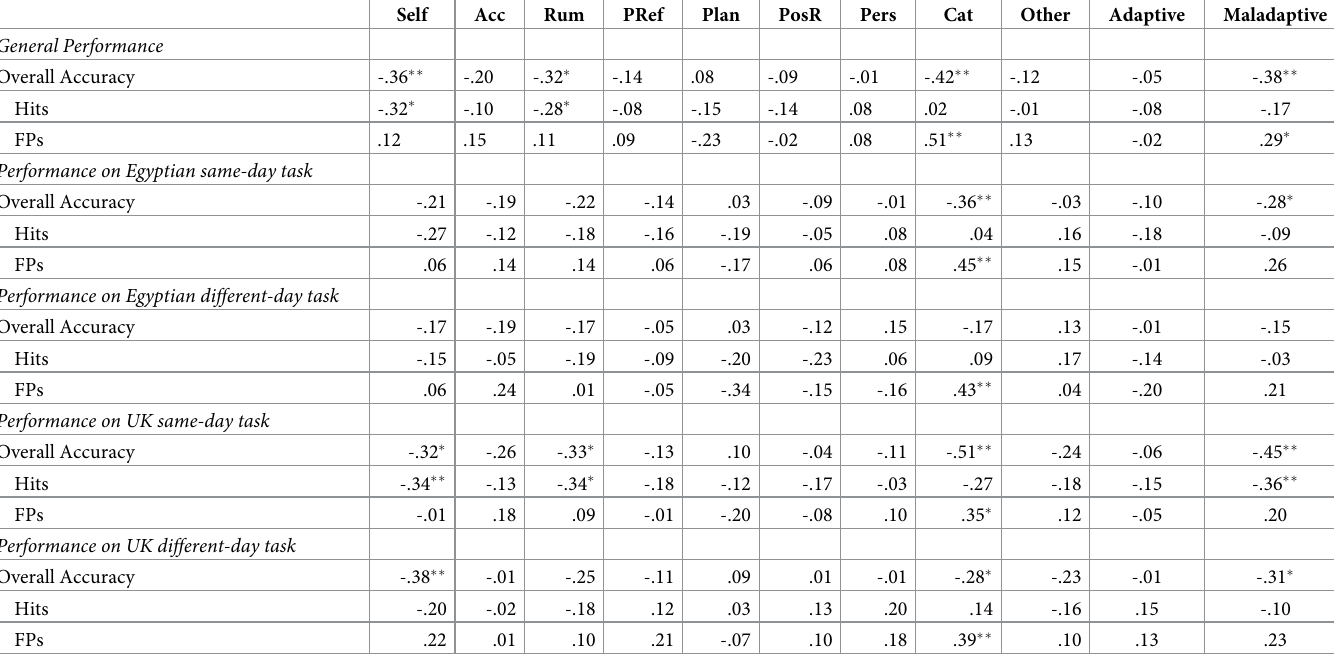
Table 7. Correlations between performances on the face-matching tasks and CERQ strategies in Experiment 3.